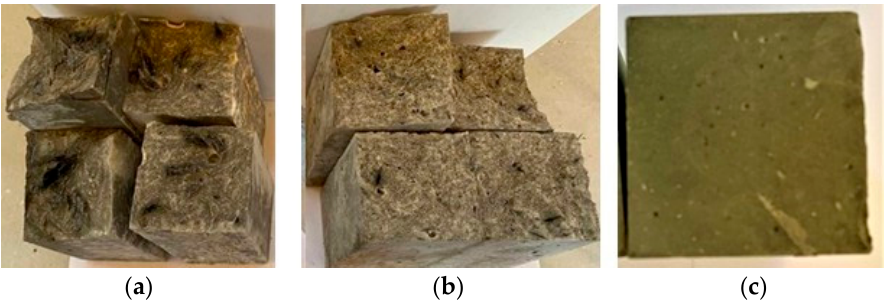
Figure 15. CFs concentration at the rupture interface in the case of ( a ) wet mixing of CFs adding CMC, ( b ) wet mixing of CFs adding CNC, and ( c ) Plain cement paste.